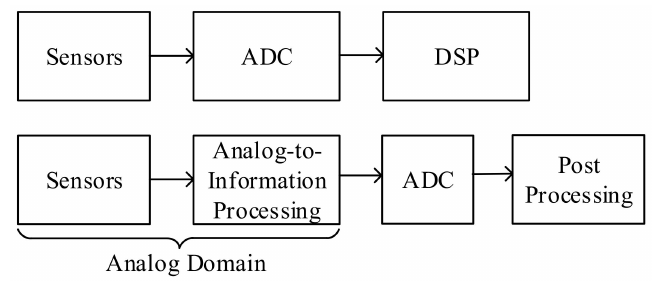
Figure 3. Tradition perception signal processing versus analog-to-information processing